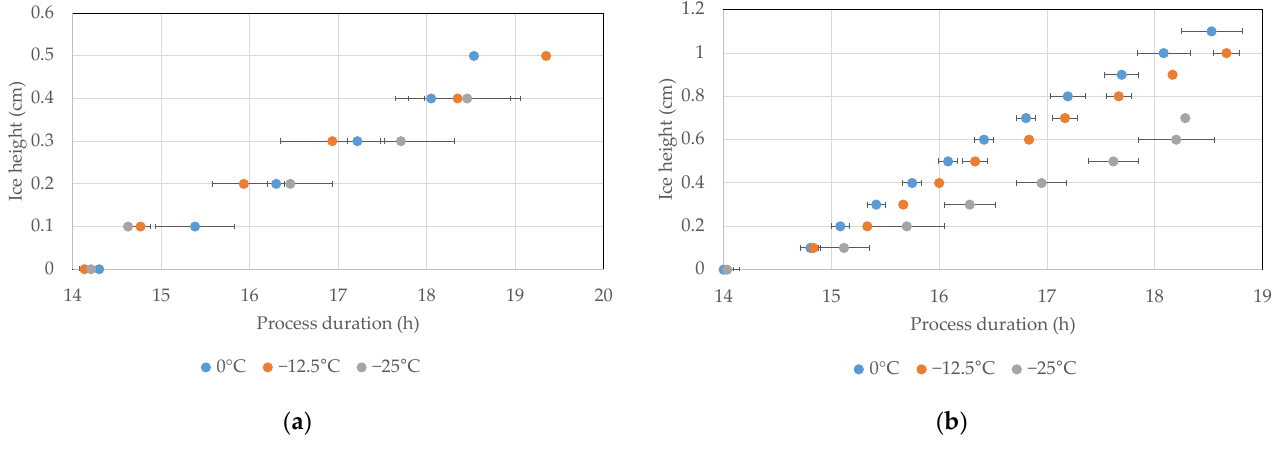
Figure 20. Ice occupation over primary drying time for ice sublimation tests ( a ) 0.05 mbar and ( b ) 0.3 mbar.